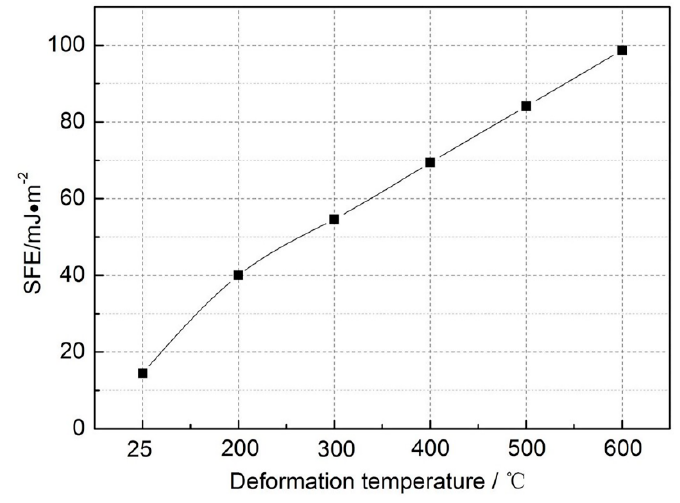
Figure 8. Estimation of SFE with the different deformation temperatures.